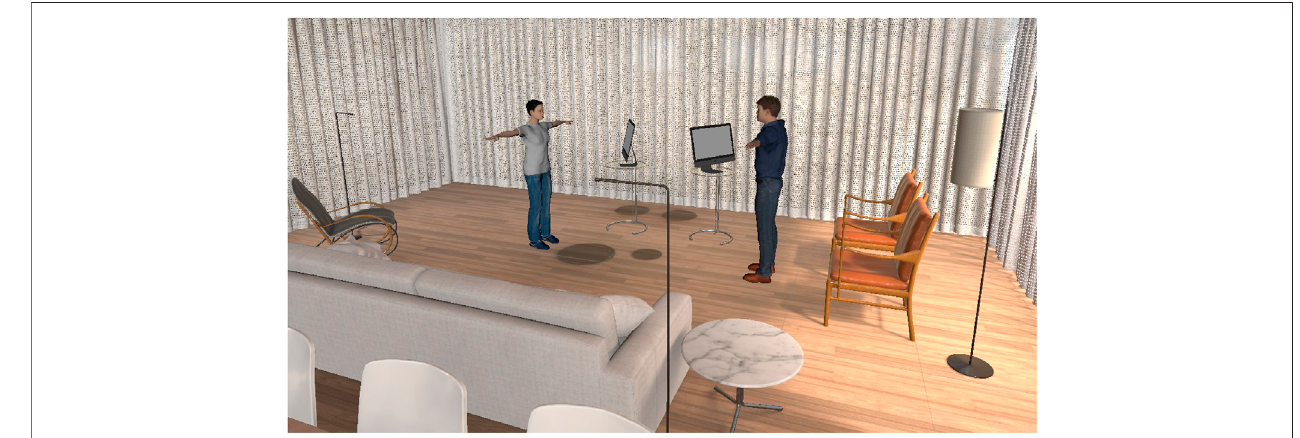
FIGURE 4 | The charade game scene.